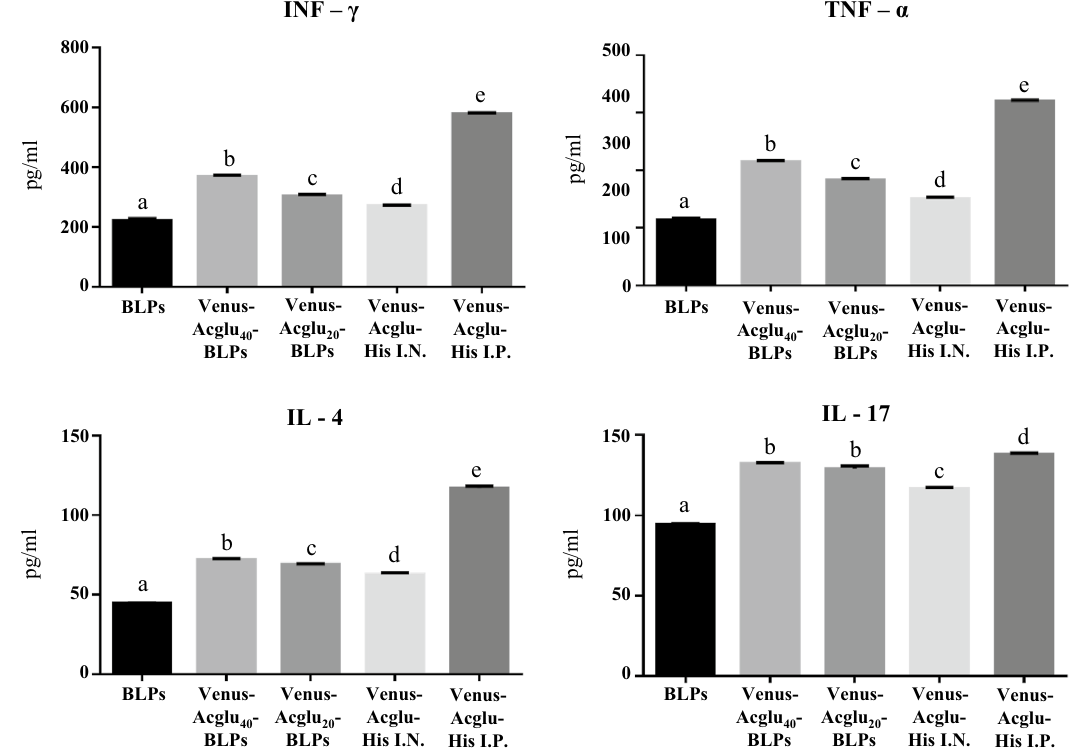
Figure 3. Immunogenicity of Venus-Acglu-BLPs027 experimental vaccine. Spleen samples were taken ten days after the boosting and immune cells were isolated. Cultured spleen immune cells were challenged ex vivo with His-Venus antigen and the concentrations of tumor necrosis factor (TNF)-α, interferon (IFN)-γ, interleukin (IL)-4 and IL-17 were determined in supernatants after 24 h of stimulation. Each experimental group consisted of five mice per group. Different letters above bars indicate significant differences among groups. p < 0.05 was considered